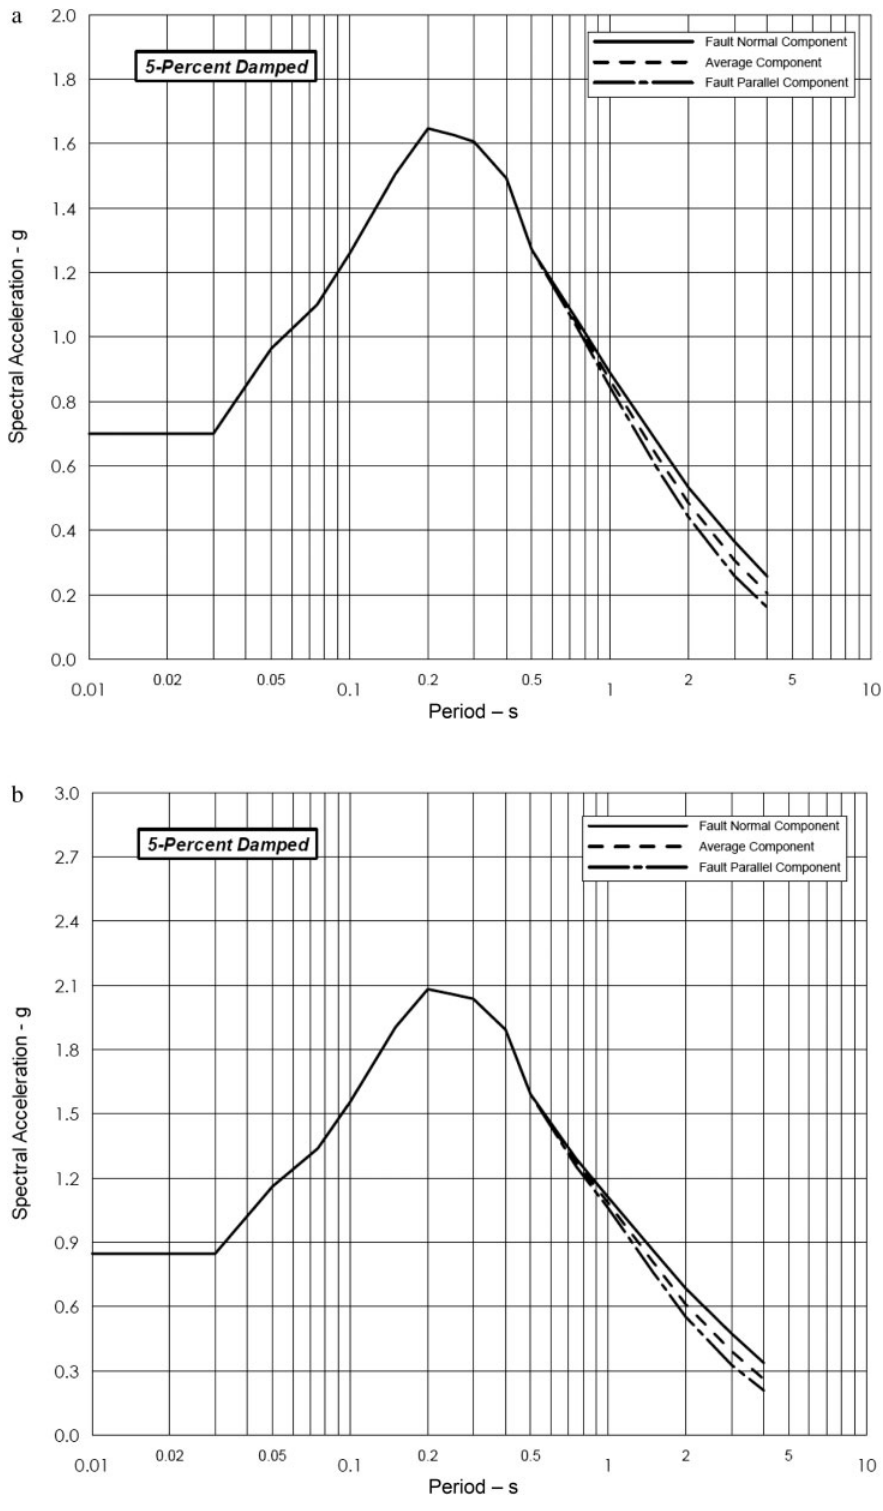
Fig. 2. Design response spectra for DBE and MCE levels (AlHamaydeh, Hussain